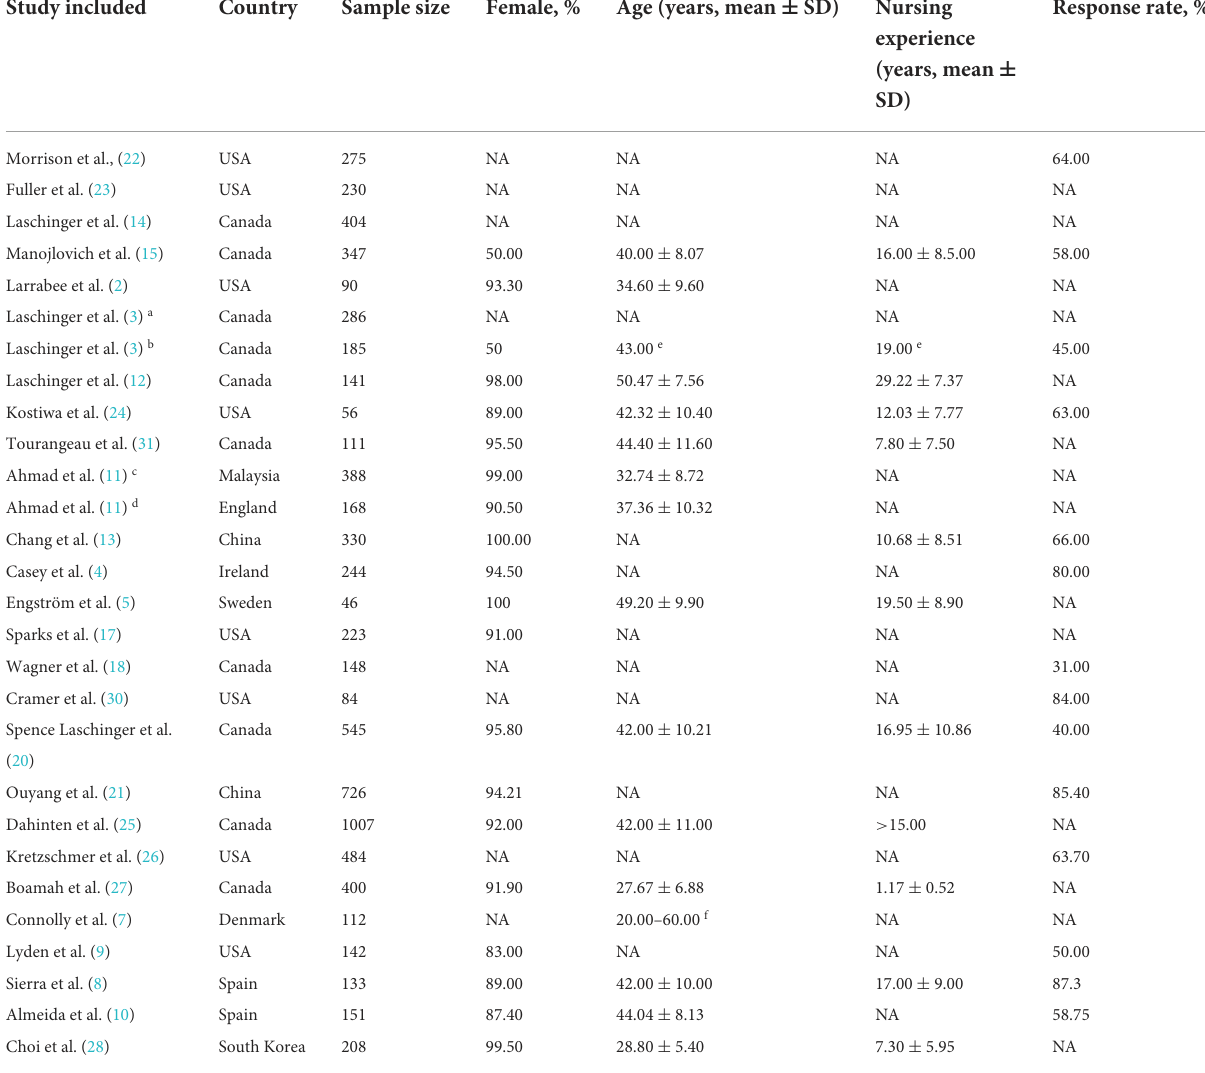
TABLE 2 Characteristics of the study